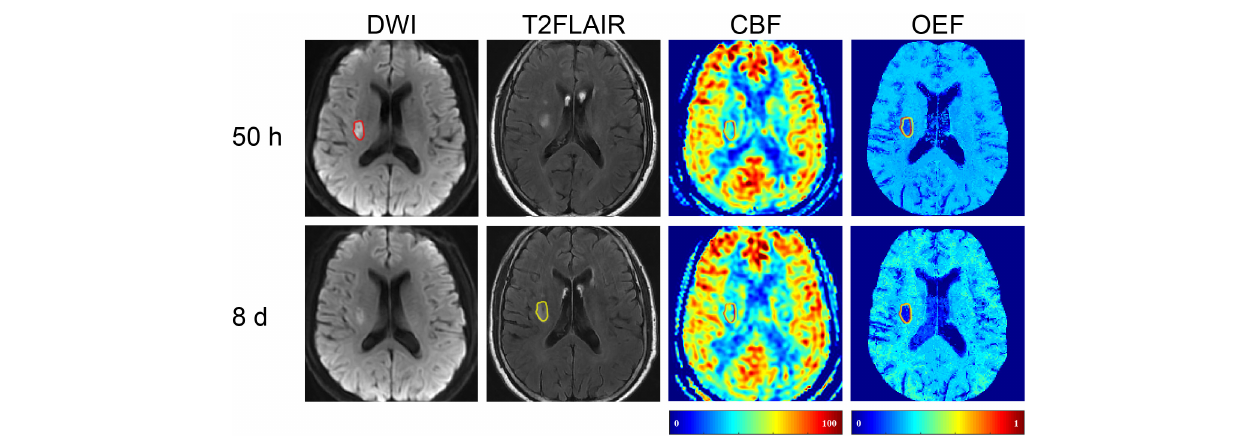
FIGURE 4 | Representative images of a 59-year-old male with left limb weakness. The FI (with a volume of 2.82 ml) on 8-day T2FLAIR (shown in yellow) was equal to the 50-h IDL (2.82 ml) on DWI (shown in red). T2FLAIR, T2 fluid-attenuated inversion recovery; DWI, diffusion-weighted imaging.